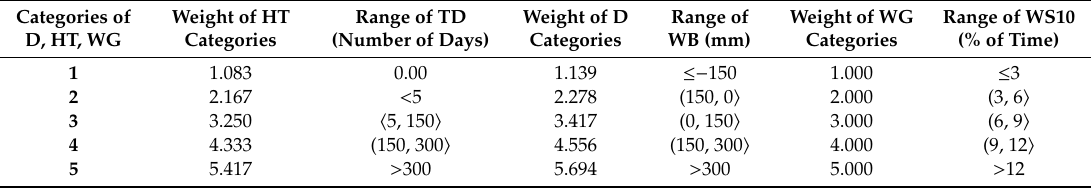
Figure 4. Categories of drought (D) risk based on long-term annual water balance (WB).